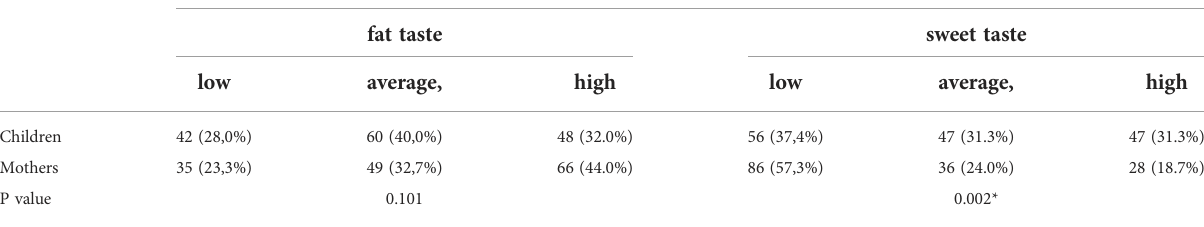
TABLE 4 Fat and sweet taste preferences for children and mother ’ s – comparison.